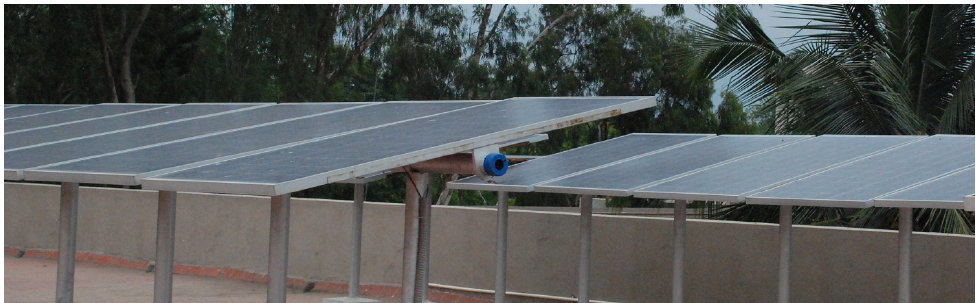
Figure 8. Array of several 300 W PV modules under test in a rooftop